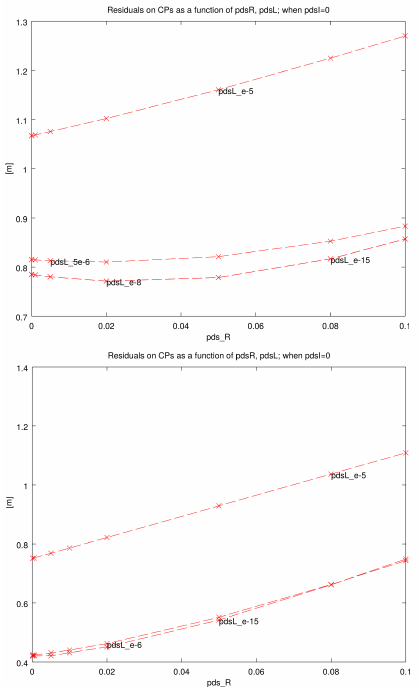
and pds last , in scenario D 0 . Top: Limoge; bottom: